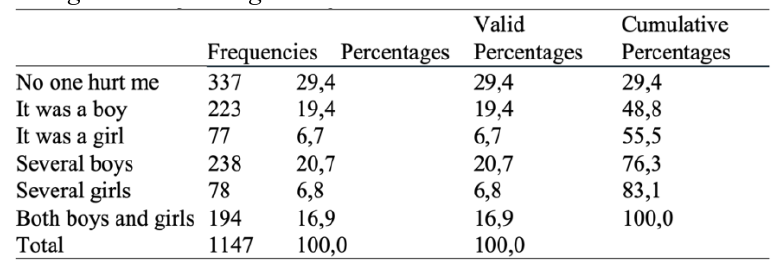
Bullies ’ gender according to the